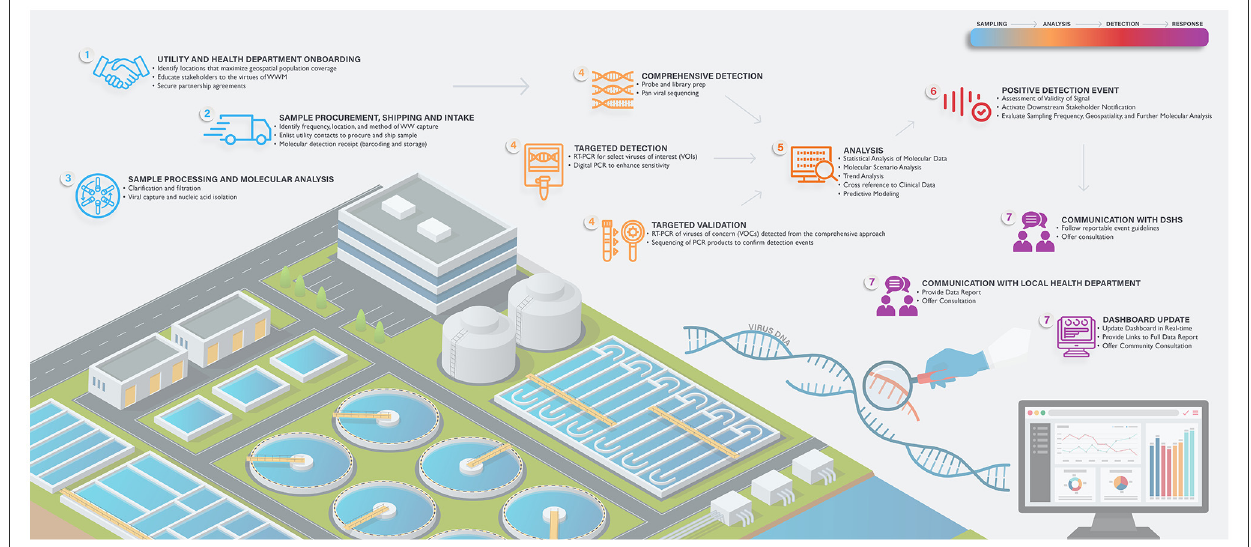
FIGURE1 Formation of an end-to-end, statewide wastewater viral epidemiology program. Step 1—utility onboarding; Step 2—sample procurement, shipping and intake; Step 3—sample processing and molecular analysis; Step 4—targeted and comprehensive detection with targeted validation;